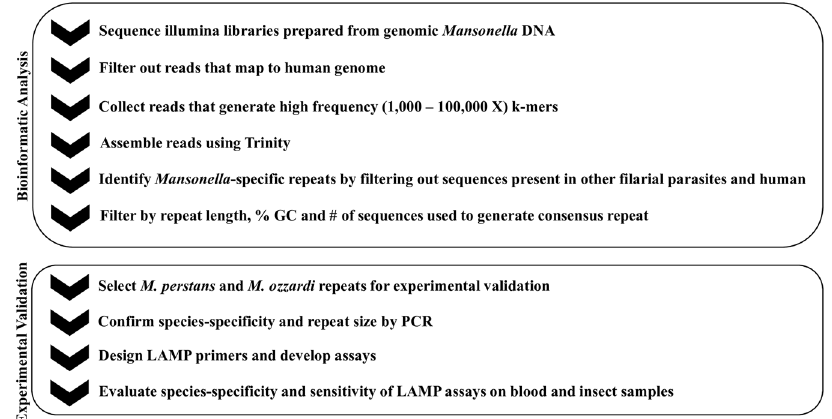
Figure 1. Bioinformatic and experimental pipeline to identify M . perstans and M . ozzardi specific repeats. Consensus repeat sequences that are at least 300 bp in length were ranked according to %GC. Candidate repeat sequences were evaluated for species-specificity and sensitivity using PCR, and the most promising candidate for each species was selected for LAMP assay development.